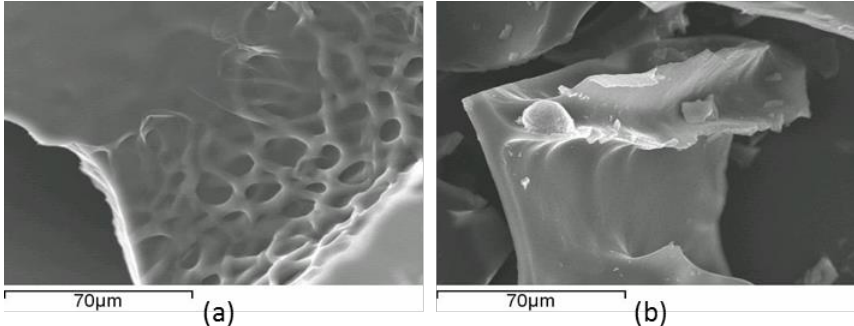
Figure 4. SEM images of ( a ) Ag + -free BSA/GLA and ( b ) BSA/GLA/Ag + (0.01). The equilibrium swelling degree (ESD%) for the three types of alginate beads without silver were recorded after they had been immersed in water or 1% w / v NaCl solution at 20 ± 1 ◦ C (Table 1). Over the 8 h study, the three sets of beads increased in mass by a similar amount in the deionised water. In contrast, both the CaALG/PGA/HSA and CaALG/QA swelled to a much smaller extent than the CaALG beads in the 1% w / v NaCl solution. Interestingly, the CaALG/QA swelling only marginally increased when going from a solution of deionised water to 1% w / v NaCl, indicating that this material is less severely damaged by Na + cations. These cations are present in blood at about 0.8% w / v . Table 1. ESD% of Alginate-based beads in deionised water and 1% w / v NaCl held at 20 ± 1 ◦ C for 8 h. CaALG CaALG/PGA/HSA CaALG/QA Medium EDS% EDS% EDS%